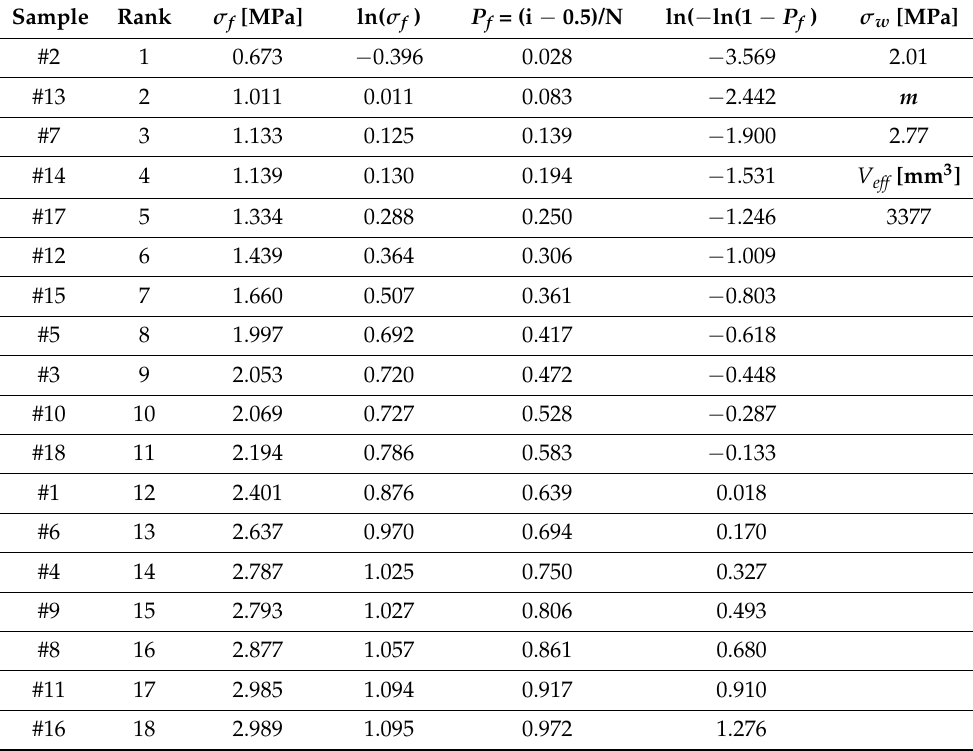
Figure 4. Crack pattern after the three-point bending in the sample #17. Top view: specimen before the test. Bottom view: tensile face and front face after the test. The structural defect that led to the failure appears in the red box. Table 1. Results of bending tests conducted with the sandstone